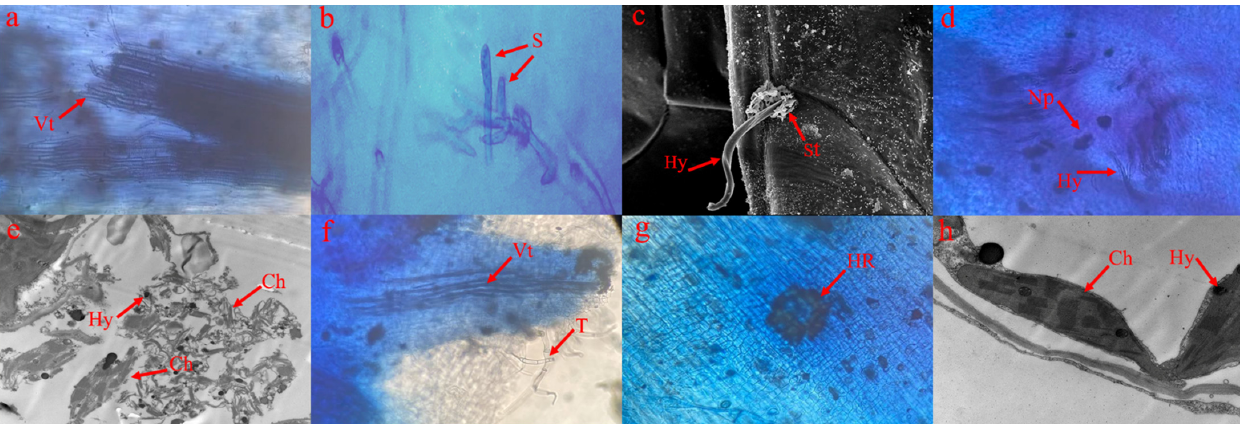
Figure 2. Trypan blue staining of tomato stem samples exposed to FORL. ( a – e ) ‘Moneymaker’ trypan blue staining at 0, 1, 2, 3, and 6 dpi; ( f – h ) ‘19912’ tomato stems dyed with trypan blue at 0, 3, and 6 dpi. Vt, vascular tissue; S, spores; Hy, hyphae; St, stomata; Np, necrotic plaque; T, trichome; HR, hypersensitive response; Ch, chloroplast.